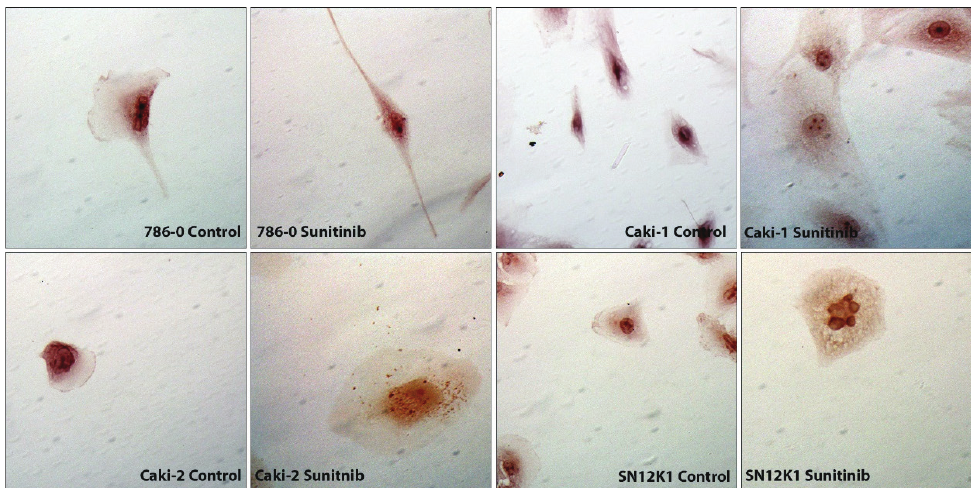
Figure 2. Morphological heterogeneity and nuclear atypia in sunitinib-resistant cells. Representative H&E images showing increased cell and nuclear size in resistant cells. The 786-0 appeared spindle-shaped whereas the SN12K1 showed multi-lobular nucleus or nuclear blebs.